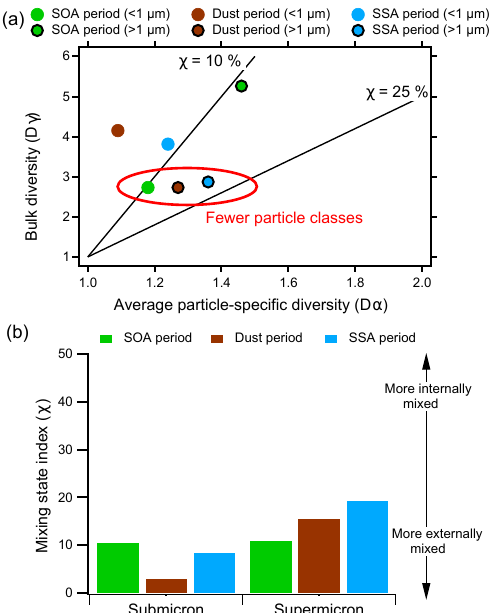
Figure 8. (a) Mixing state diagram showing the bulk diversity and average particle-specific diversity and (b) mixing state indices for sub- and supermicron particles during the SOA, dust, and SSA pe- riods. For submicron particles, contributions by different sources impact mixing